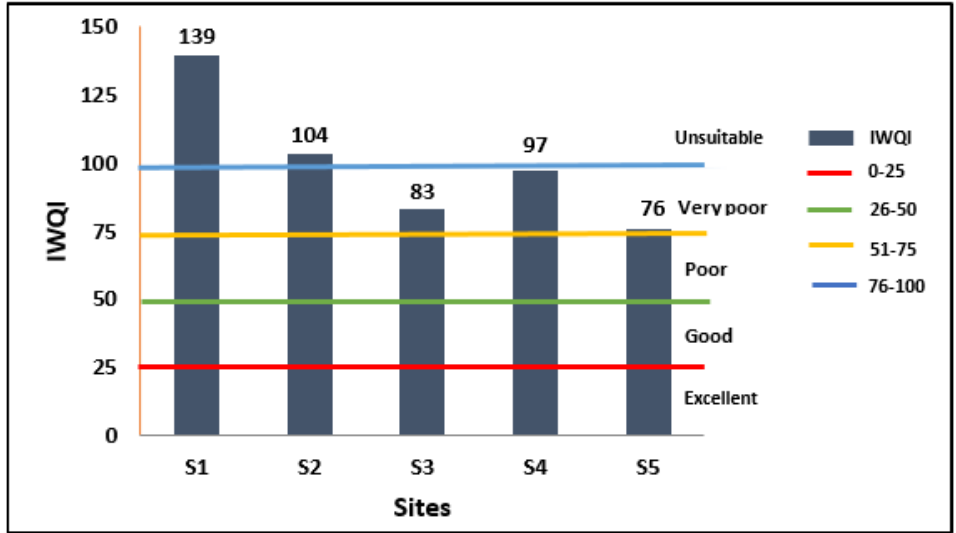
Figure 6. The values of IWQI of the groundwater samples.